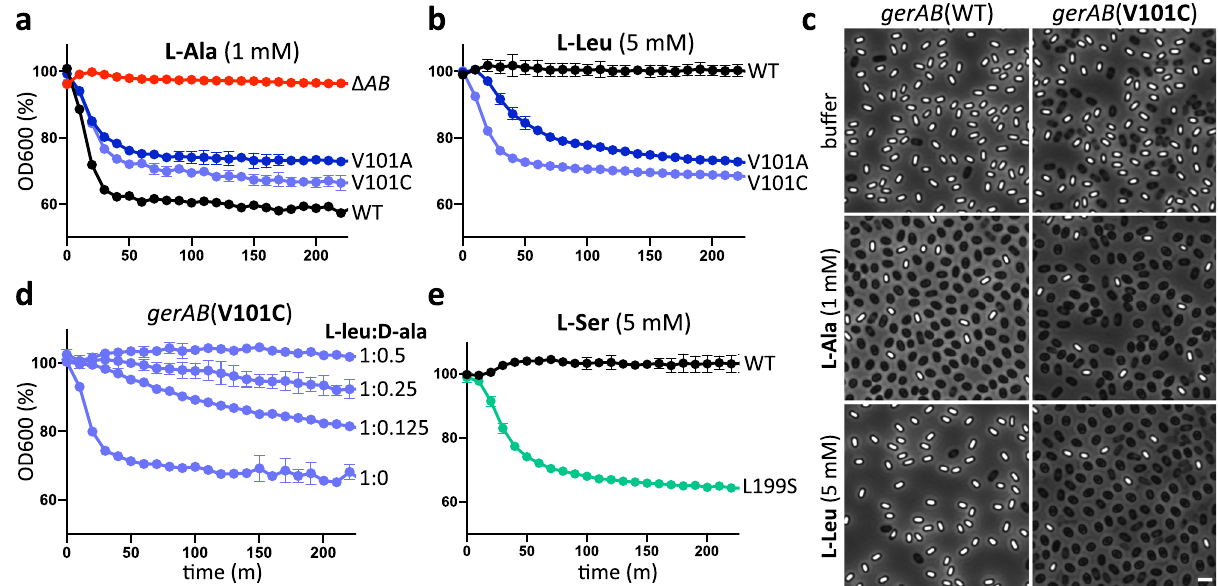
Fig. 3 Mutations in the putative L -alanine-binding pocket of GerAB enable spores to respond to L -leucine or L -serine. a Spores harboring gerAB (V101A) or gerAB (V101C) germinate in response to 1 mM L -alanine with kinetics similar to wild-type (WT). b V101A and V101C mutant spores but not wild-type also germinate in response to 5 mM L -leucine. c Representative phase-contrast images of wild-type and gerAB (V101C) spores after 100 min incubation with buffer, 1 mM L -alanine, or 5 mM L -leucine. Larger fi elds can be found in Supplementary Fig. 9. Scale bar, 2 µ m. d D -alanine inhibits germination of gerAB (V101C) spores in response to L -leucine. Spores were incubated with 5 mM L -leucine with or without D -alanine at 0.625, 1.25, 2.5 mM, and OD 600 was monitored. The decrease in optical density in the V101 mutants was reproducibly less than wild-type in the germination assays and is likely due to spontaneous germination of a subset of the spores during their puri fi cation. e Spores harboring gerAB (L199S) germinate in response to 5 mM L -serine. Representative data from one of three biological replicates with two technical replicates are shown. Error bars in a , b , d , e indicate ± SD of two technical